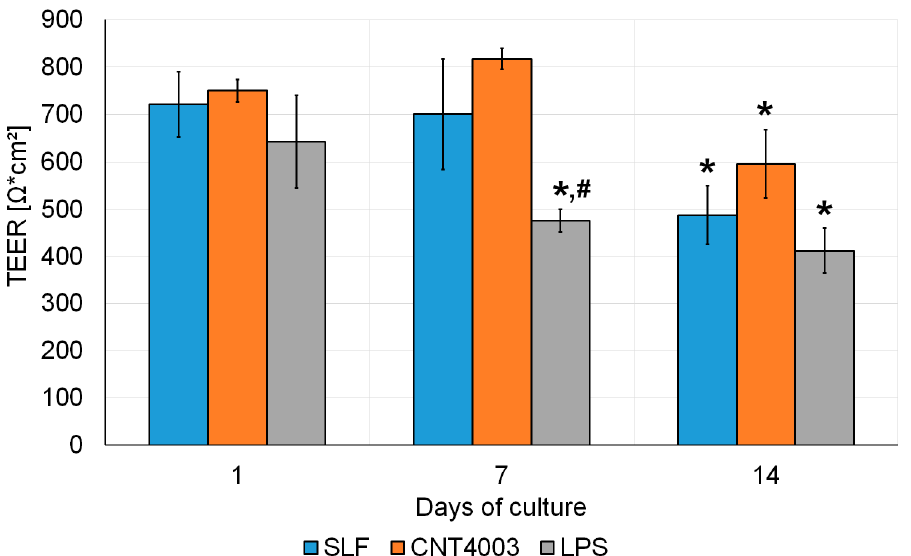
Figure 2. Time-dependent changes of transepithelial electrical resistance (TEER) in Calu-3 cells exposed to simulated lung fluid (SLF) alone, LPS or SLF containing CNT4003. Significant changes compared to 1 d are indicated by an asterisk and significant differences between treated and control cells by a hash.